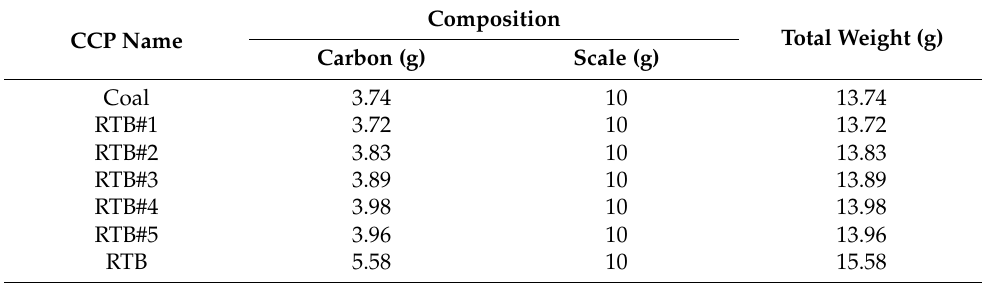
Table 5. Carbon and scale in the CCP at the C/O molar ratio of 1.5.